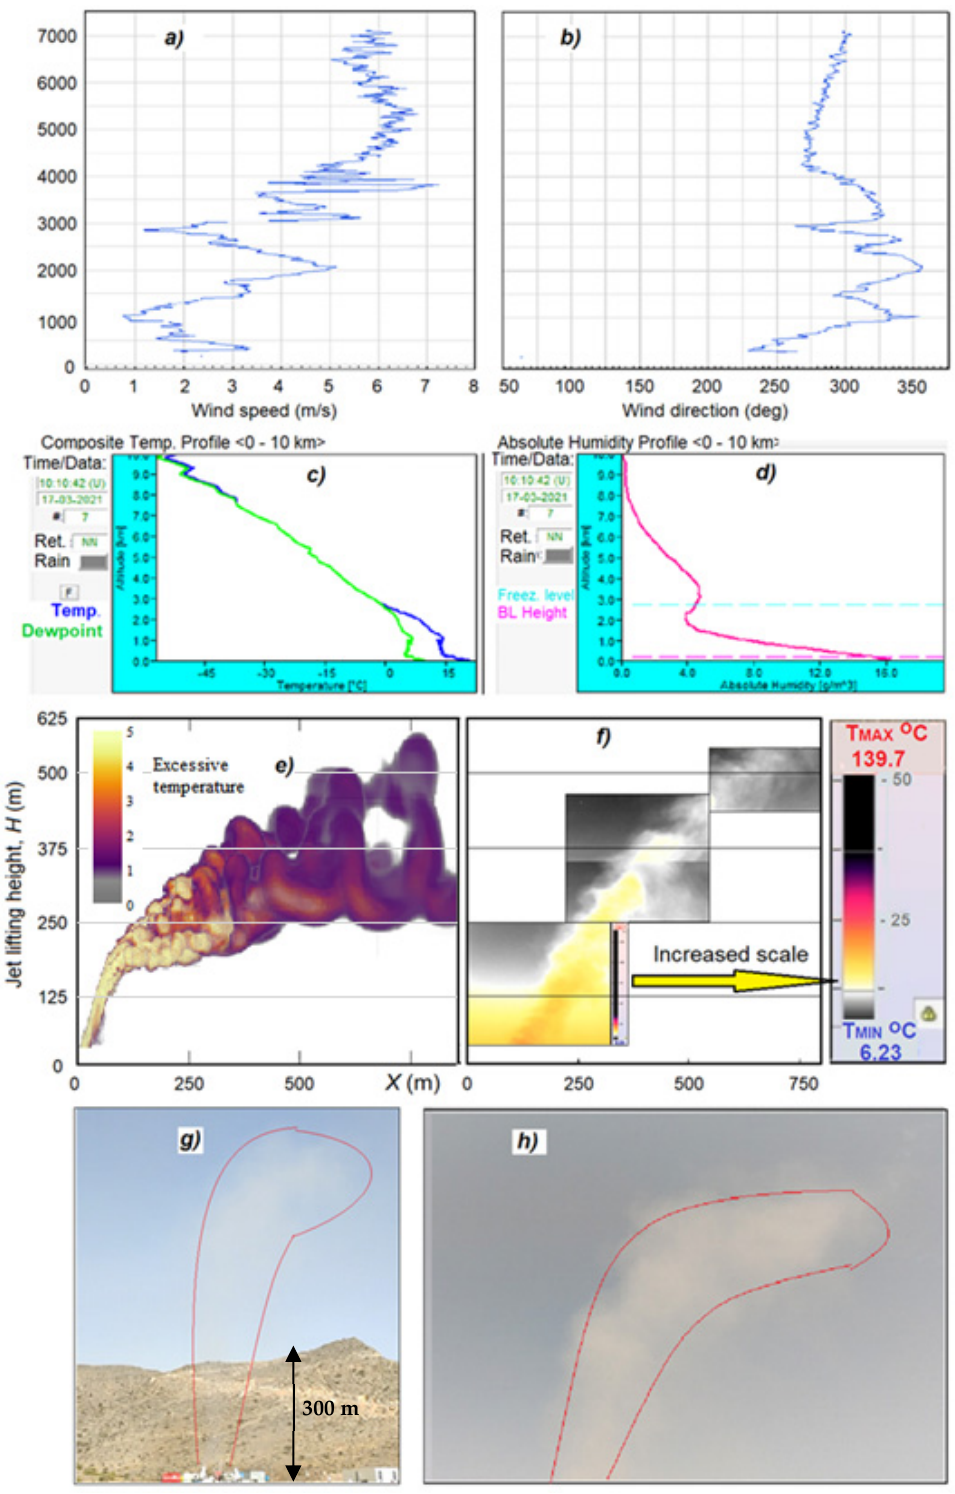
Figure 7. Comparison of the simulated and observed jet characteristics, initiated at an altitude of 1595 m above sea level during trial field experiment on Jebel Jais Mountain of UAE on March 17, 2021. Wind speed ( a ) and direction ( b ) measured by Wind Lidar Halo Photonics Streamline XR; temperature ( c ) and specific humidity ( d ) profiles measured by microwave radiometer RPG HATPRO-G4 PRO; simulated jet shape ( e ); combined thermal images of jet ( f ) measured by infrared scanning thermograph IRTIS-2000C at 3 viewing angles; visual images by GoPro Hero-9 Camera ( g and h ).